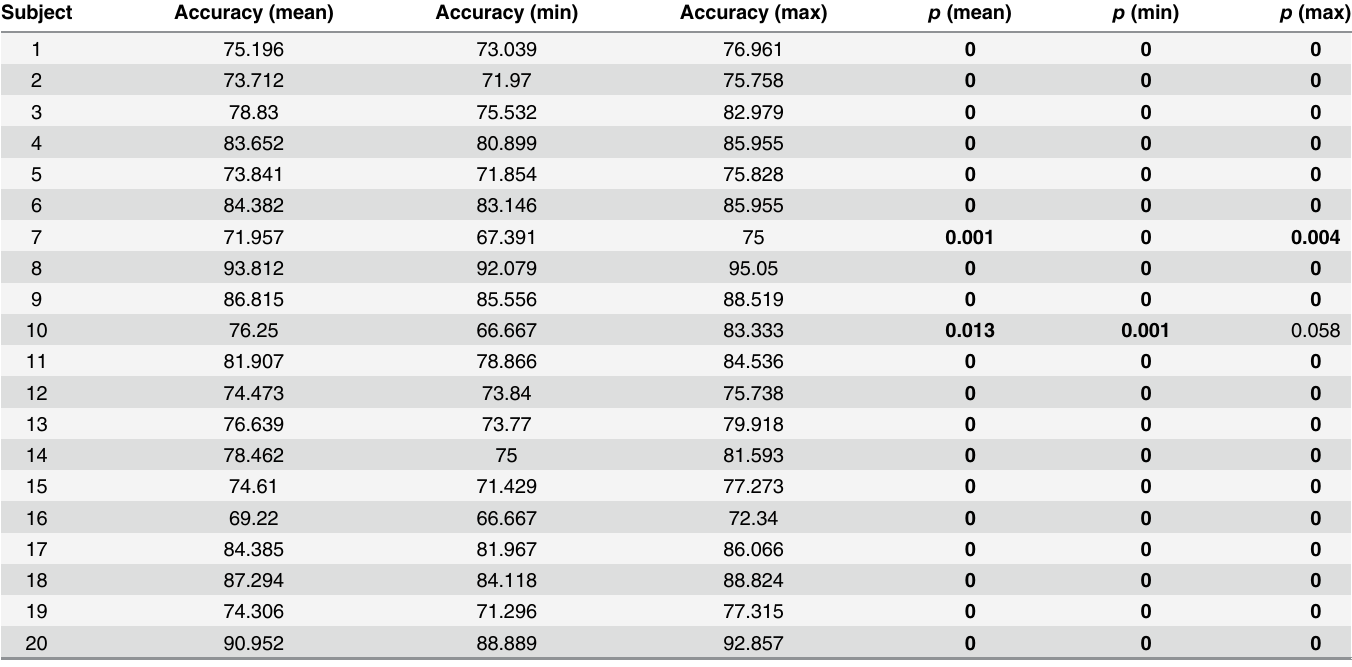
Table 3. Results Flanker Task Pe